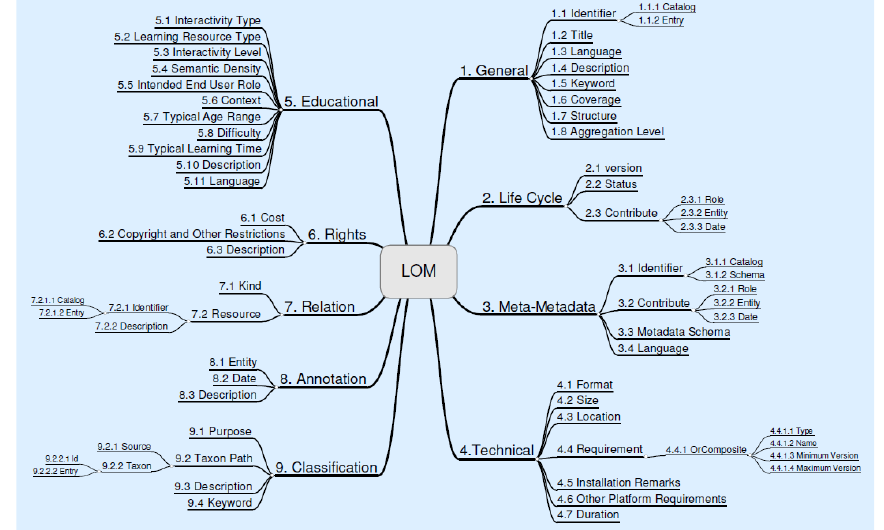
Fig. 2. A schematic representation of the hierarchy of elements in the LOM data model (WhatIsLOM 5